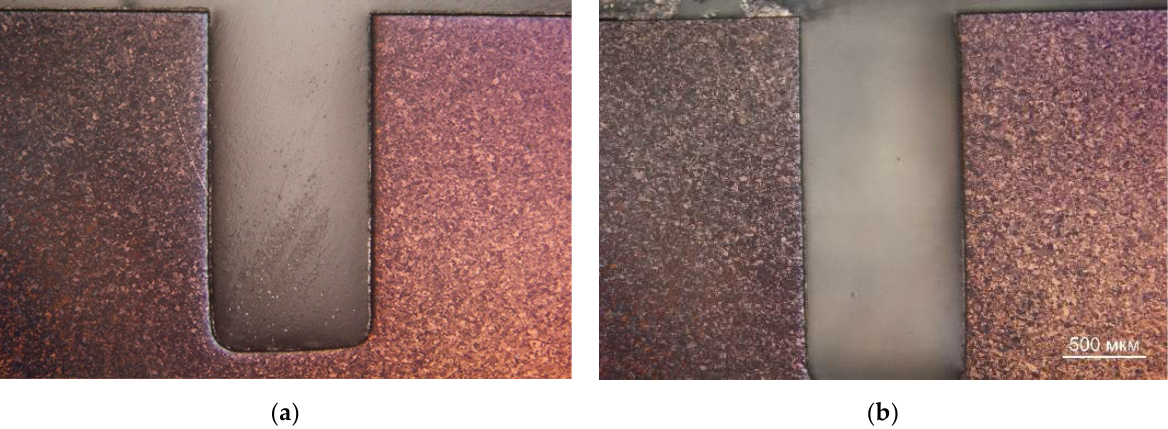
Figure 5. Microstructure of the samples cross section (360 °С): ( a ) Be-1 (10 impulses); and ( b ) Be-4 (100 impulses).